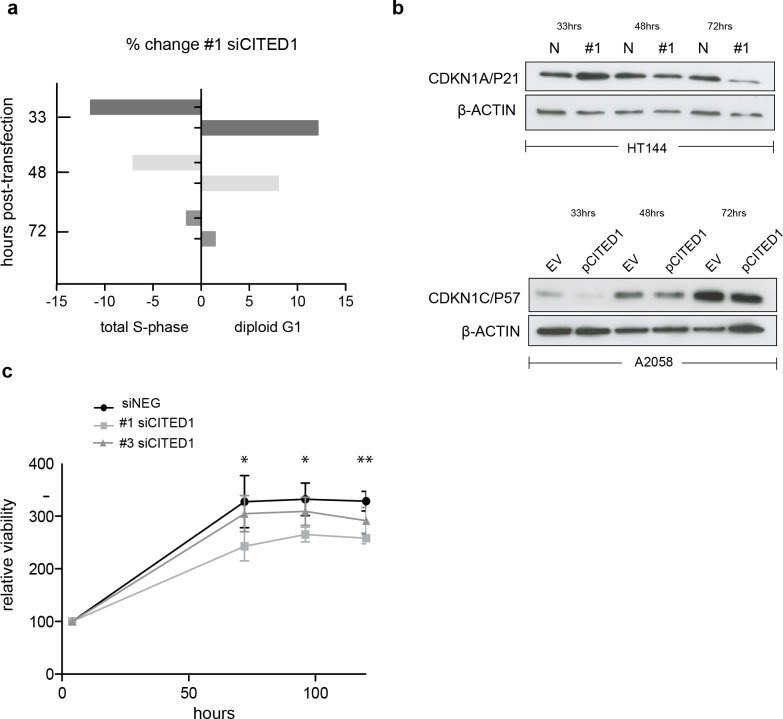
CITED1 silencing restrains cell cycle progression and reduces cell viability.(A) A bar chart showing the % change in cell cycle distribution in #1 siCITED1 treated HT144 cells relative to siNEG treated HT144 cells. The reduction in the total S-phase is shown at 33 h, 48 h and 72 h post-transfection in addition to the corresponding increase in the diploid G1 fraction. (B) Western blots showing upregulation of CDKN1A/P21 following CITED1 silencing in HT144 cells and suppression of CDKN1C/P57 following CITED1 overexpression in A2058 cells. (C) An Alamar Blue based metabolic assay shows a reduction in cell viability over 5 days in HT144 cells treated with siCITED1 relative to those treated with siNEG. Stars indicate significance for siNEG vs. #1 siCITED1 where ∗∗∗
p < = 0.0005, ∗∗
p < = 0.005 and ∗
p < = 0.05. In the case of siNEG vs. #1 siCITED1, the difference is significant (*) at 96 and 120 h.